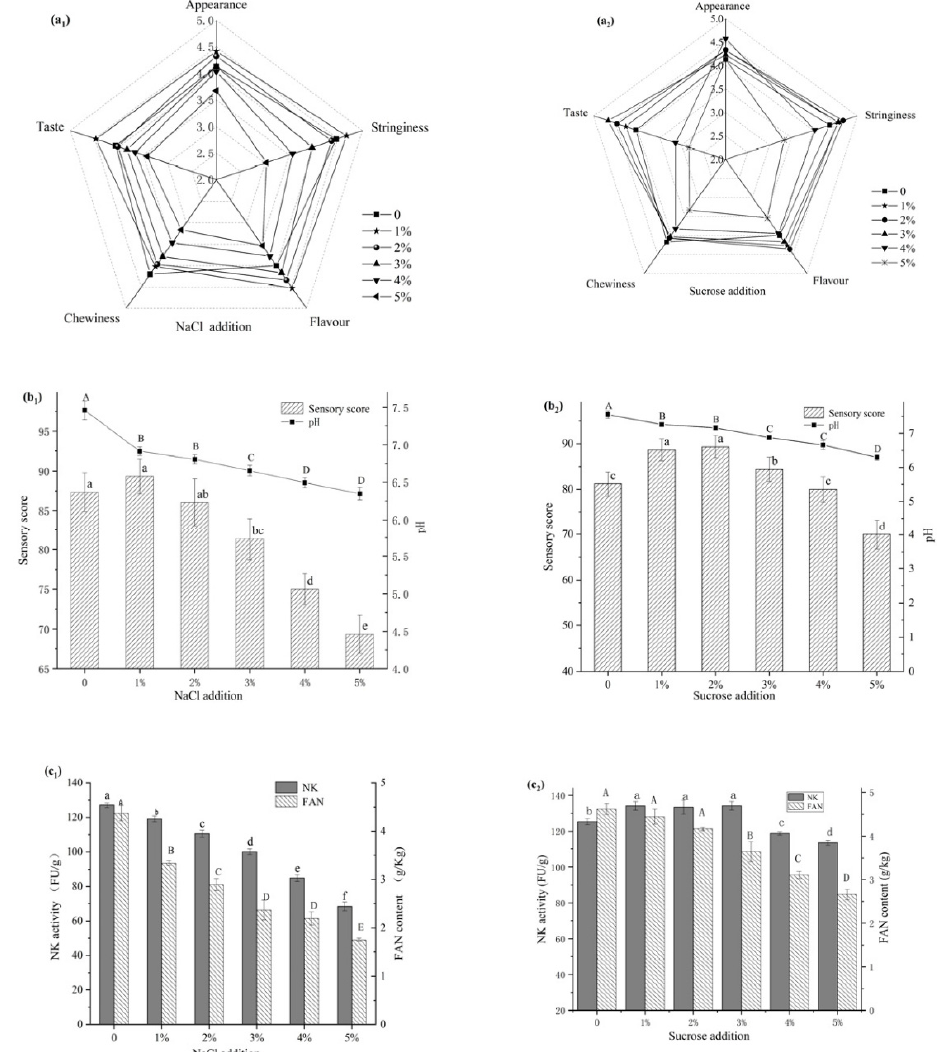
Figure 1. Effects of NaCl addition ( a 1 , b 1 , c 1 ) and sucrose addition ( a 2 , b 2 , c 2 ) on natto fermentation. Different letters above each bar means significant